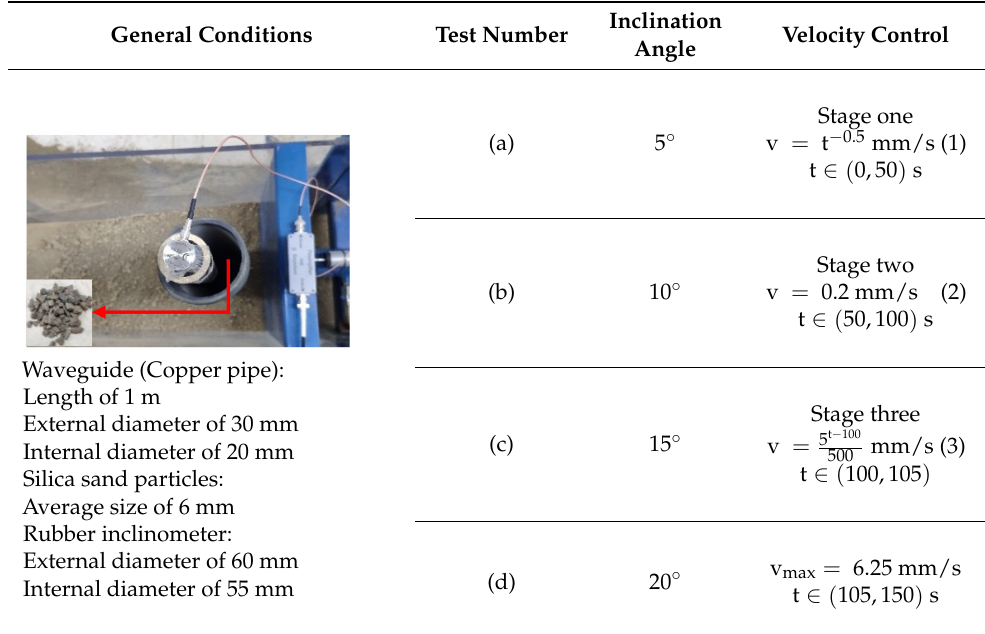
Table 2. Details of the four